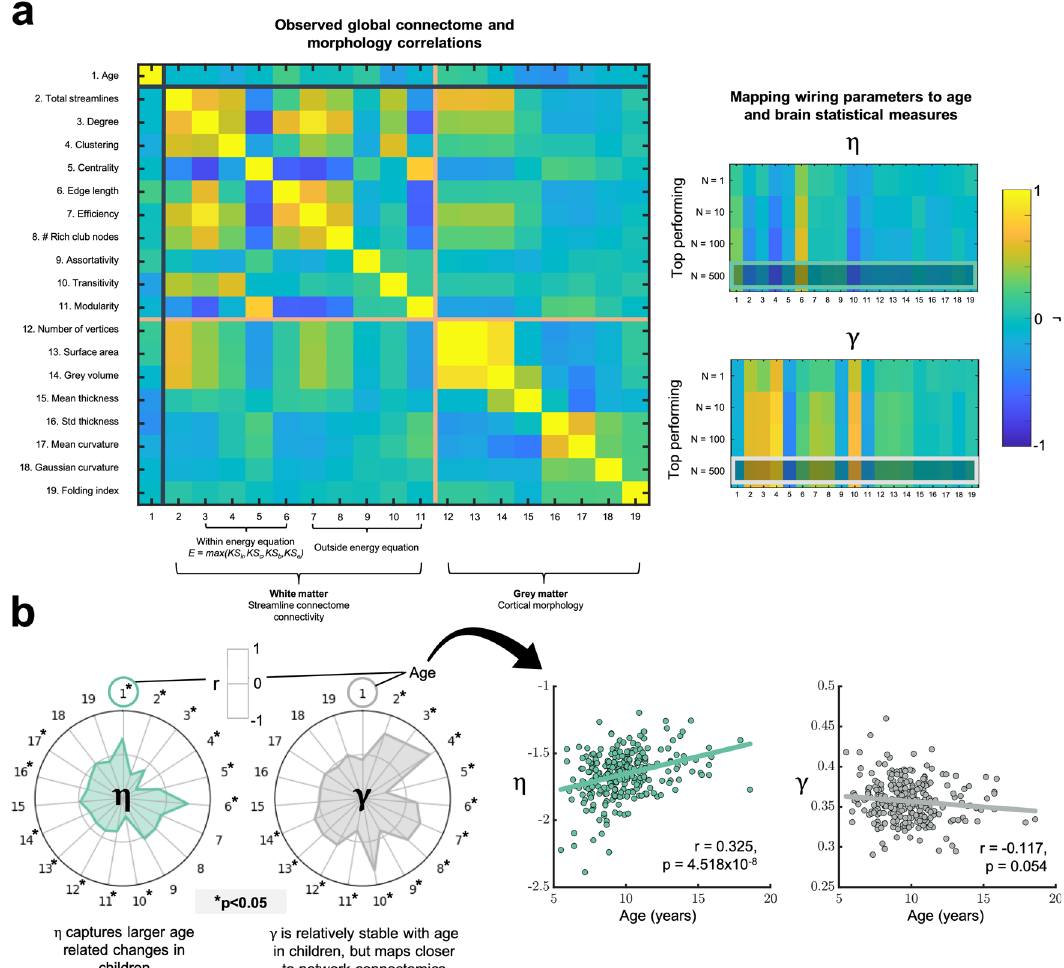
Fig. 4 Statistical properties of the connectome and cortical morphology, and their relationships with wiring parameters and age. a The correlation matrix of connectome and morphological fi ndings show how each measure correlates with every other measure. Measures 3 – 6 were included in the energy equation. Measures 7 – 11 are connectome measures not included in the energy equation. Measures 12 – 19 are cortical morphological measures. η and γ are each signi fi cantly correlated with a range of measures, both inside and outside of the energy equation. Correlation coef fi cient matrices are shown, the bottom row of which is highlighted and is re fl ected in the above radar plots (middle), in addition to the signi fi cance matrix (bottom), across varying numbers of top performing parameters, for each of the 19 measures investigated. b Radar plots depict the correlations between all measures and η (left) and γ (right) averaged across the top N = 500 parameters in the parameter space. All statistics were computed via two-tailed linear correlations, quoting the Pearson ’ s correlation coef fi cient. The asterisk, *, re fl ects signi fi cant correlations at p < 0.05. Note, the inner edge of the radar plot re fl ects negative correlations and the outer edge re fl ects positive correlations. Speci fi c results for variable top performing parameters are provided in Supplementary Table 3. Further scatter plots are provided highlighting the relationship of wiring parameters with age. η has a signi fi cantly positive relationship with age ( r = 0.325, p = 4.518 × 10 − 8 ) while γ has a weak non-signi fi cant negative relationship with age ( r = − 0.117, p =